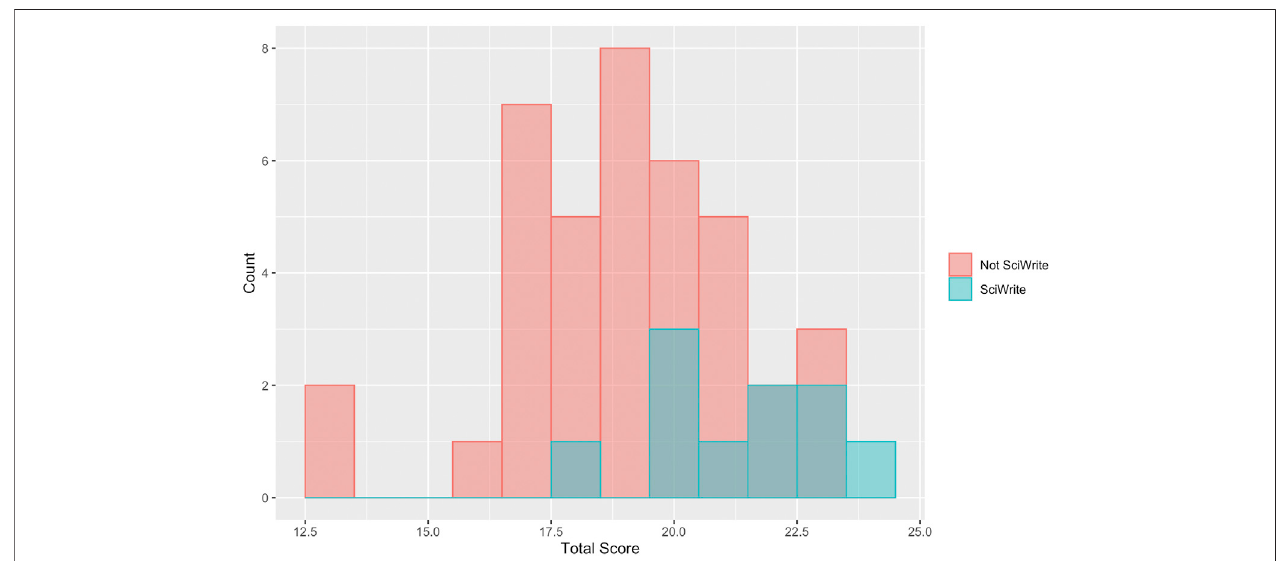
FIGURE2| Frequencydistributionoftotalrubricscoresforthesis/dissertationproposalswrittenbygraduatestudentstrainedintheSciWriteprogramvs.thosenot trained in this program ( “ Not SciWrite ” ).